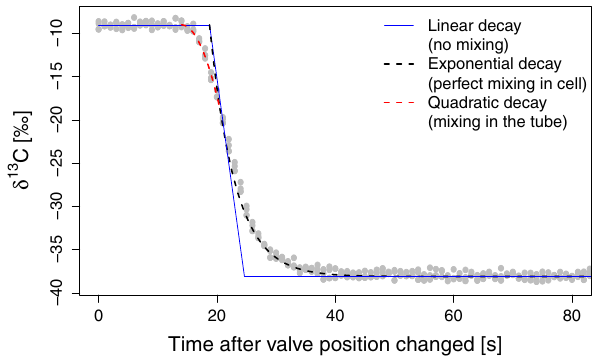
Figure 8. The response time of our experimental setup can be di- vided into three phases with different dominant mechanisms: di- rectly after switching, it took approximately 14s to flush the tub- ing, the adjacent 4s were dominated by the mixing processes in the tubes before the gas entered the measuring cell (quadratic fit) and finally we observed a response behavior that is dominated by mixing processes within the measuring cell (exponential fit) with a characteristic decay time of τ 10% = 10s for δ 13 C. These response times were similar for δ 18 O (not shown). The linear fit shown here describes a first order approximation of the theoretical cell response for the (unrealistic) assumption that there is no mixing in the measurement cell. From this assumption, it can be derived that the δ values would show a dominantly linear decay with the slope m = (δ new − δ old )/τ theoretical and the theoretical instrument cell response time τ theoretical = p × V/(cid:56) , with pressure p , Vol- ume V and flow rate (cid:56) . In our case δ new − δ old = − 29‰ and thus τ theoretical = 5 . 9s.